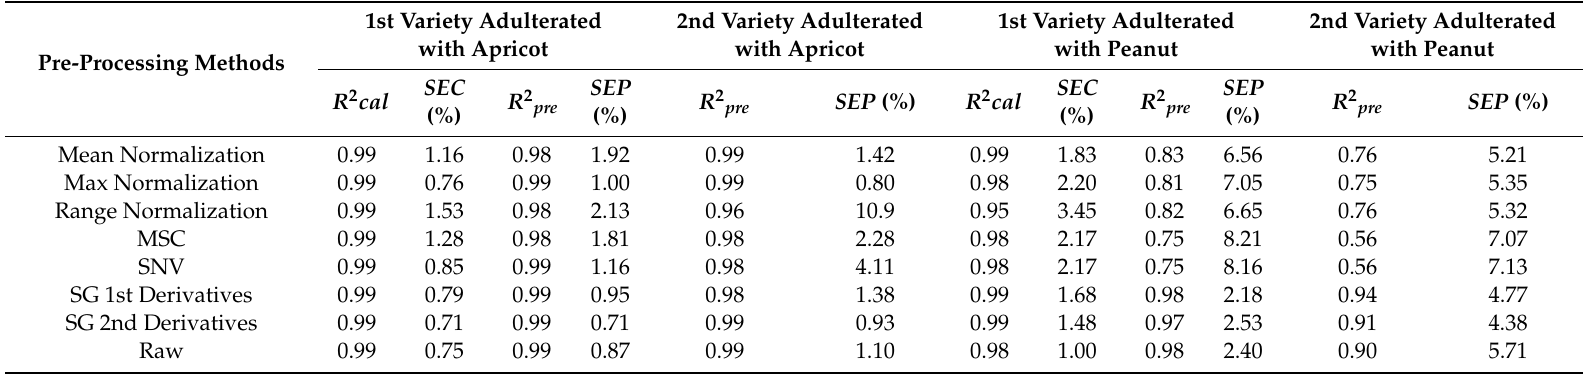
Table 3. Presents the results obtained from the developed model with the first variety of almonds when used to predict the second variety of adulterated almond for the four groups of data, which were pre-processed with various techniques. The SG-2nd derivatives provided the best predictive result for both